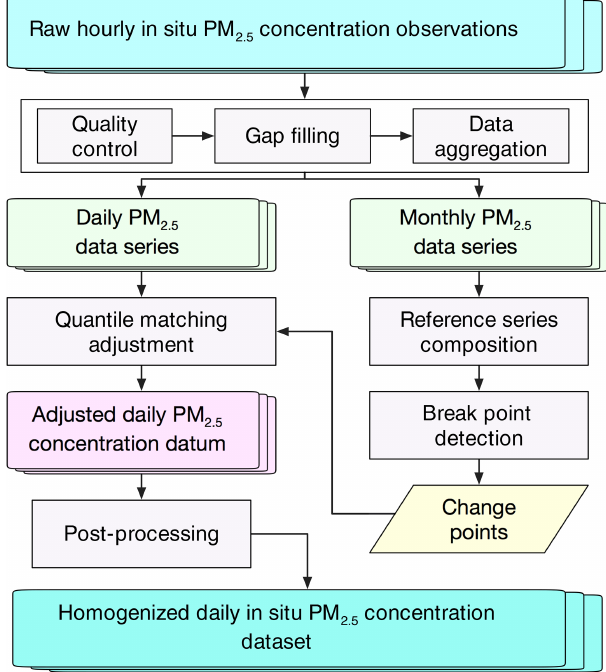
Figure 1. A schematic flowchart for the creation of a homogenized daily in situ PM 2 . 5 concentration